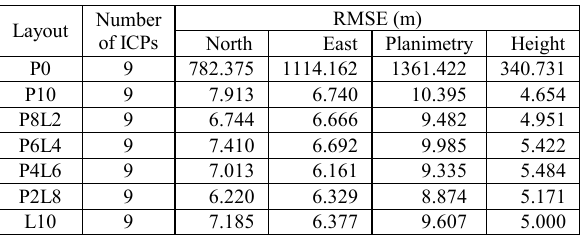
Table 3. Direct georeferencing accuracy of the ZY-3 TLC images in the dataset 2.